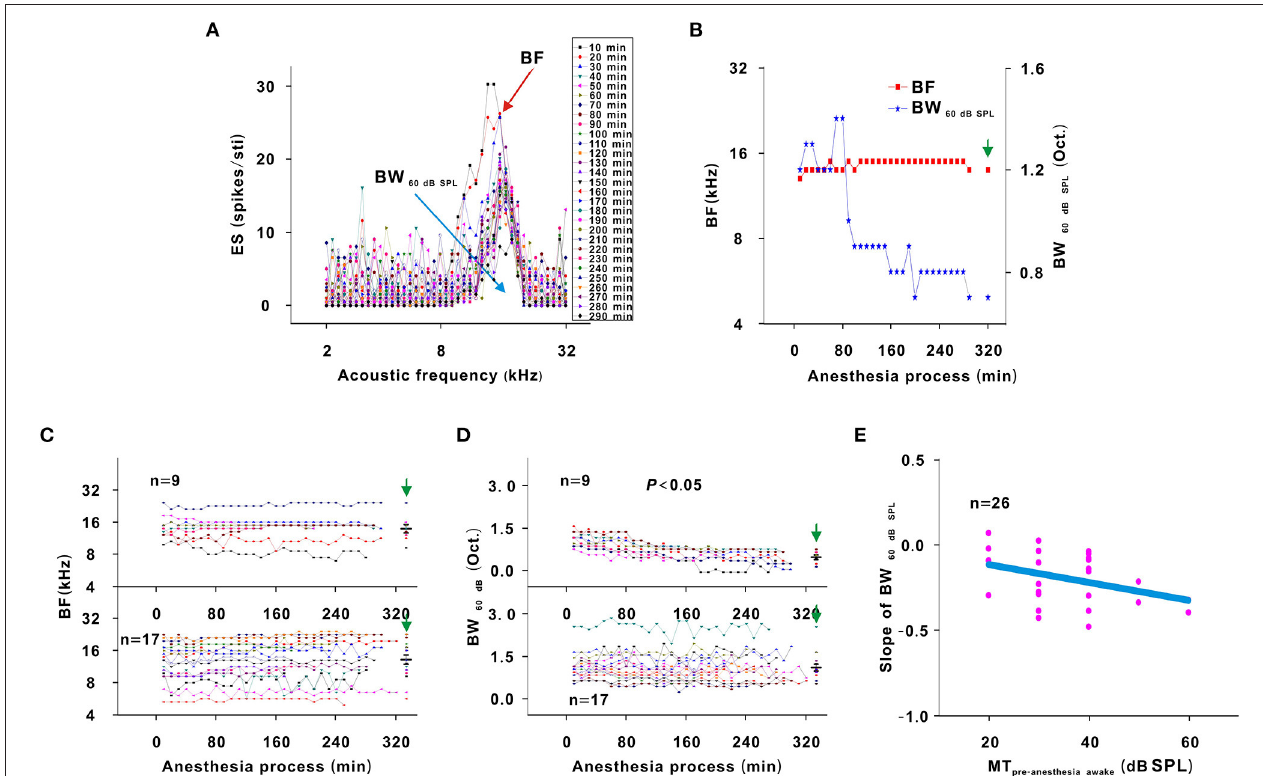
FIGURE 5 | Changes in the frequency tuning of neurons. (A) ES changes with acoustic frequency. The highest dot of each curve labeled BF (red arrow). The blank width of each curve was the BW 60 dB SPL (blue arrow). (B) BF and BW 60 dB SPL changes with anesthesia time (red curve and left ordinate for the BF, blue curve and right ordinate for the BW 60 dB SPL ), hereafter, the BF- and BW 60 dB SPL -time curves. (C) Summary of the BF-time curves in neurons changed MT (upper curves) and neurons unchanged MT (lower curves) [Upper curves: first four recording sessions vs. middle four recording sessions vs. last four recording sessions vs. pre-anesthesia awake state (14.552 ± 3.697) vs. (14.540 ± 4.136) vs. (14.557 ± 4.290) vs. (14.406 ± 4.246) kHz, F = 0.003, P = 1.000, one-way ANOVA; Lower curves: first four recording sessions vs. middle four recording sessions vs. last four recording sessions vs. pre-anesthesia awake state (13.033 ± 4.904) vs. (14.126 ± 5.248) vs. (14.407 ± 5.569) vs. (14.105 ± 5.291) kHz, F = 0.262, P = 0.878, one-way ANOVA]. (D) Summary of the BW 60 dB SPL -time curves in neurons changed MT (upper curves) and neurons unchanged MT (lower curves) [Upper curves: first four recording sessions vs. middle four recording sessions vs. last four recording sessions vs. pre-anesthesia awake state (1.075 ± 0.231) vs. (0.678 ± 0.175) vs. (0.511 ± 0.217) vs. (0.522 ± 0.233) octave (Oct.), F = 13.492, P = 7.363 × 10 − 6 , one-way ANOVA,